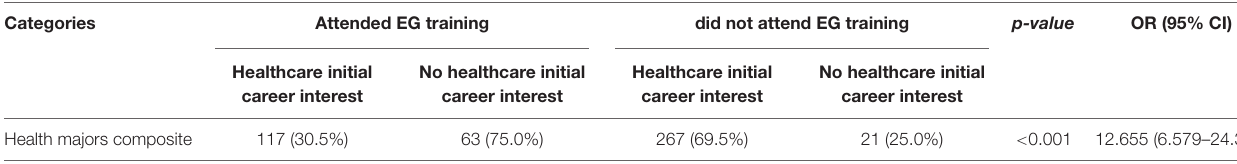
TABLE 3 | Empower Generations training attendance and the initial career interest in both groups.